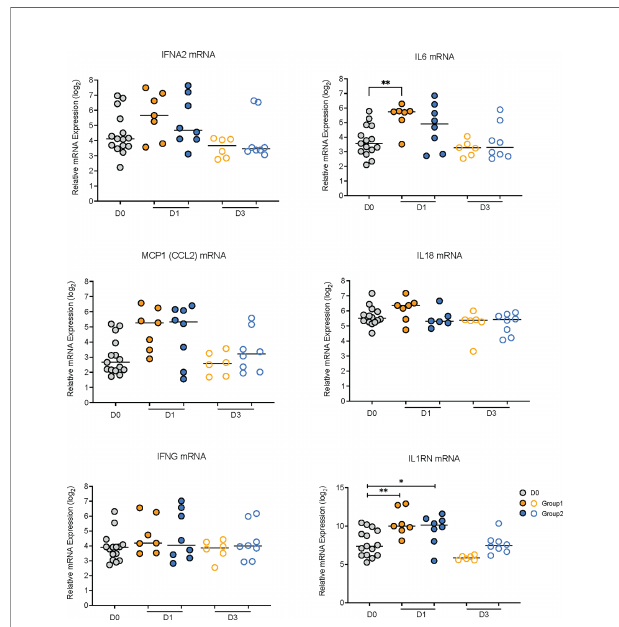
FIGURE 3 | Relative mRNA expression values of genes encoding elevated plasma cytokines. The graphs show relative log 2 mRNA levels of IFNA2, IL6, MCP1, IL18, IFNG, and IL1RN on day 0 (vaccine prime; grey circles) and on days 1 ( fi lled circles) and day 3 (open circles) post vaccination for Group 1 (orange circles) and Group 2 (blue circles) animals. Horizontal lines represent median values. Data between two time points were compared by Mann-Whitney test with * or ** indicating p < 0.05 or p < 0.01,